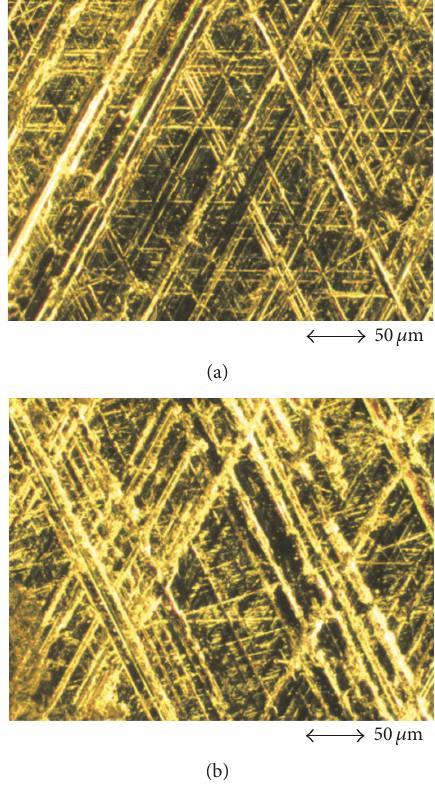
Figure 4: Microscope images after the tribometer experiment. (a) Reference material, example of axial abrasive scratches on